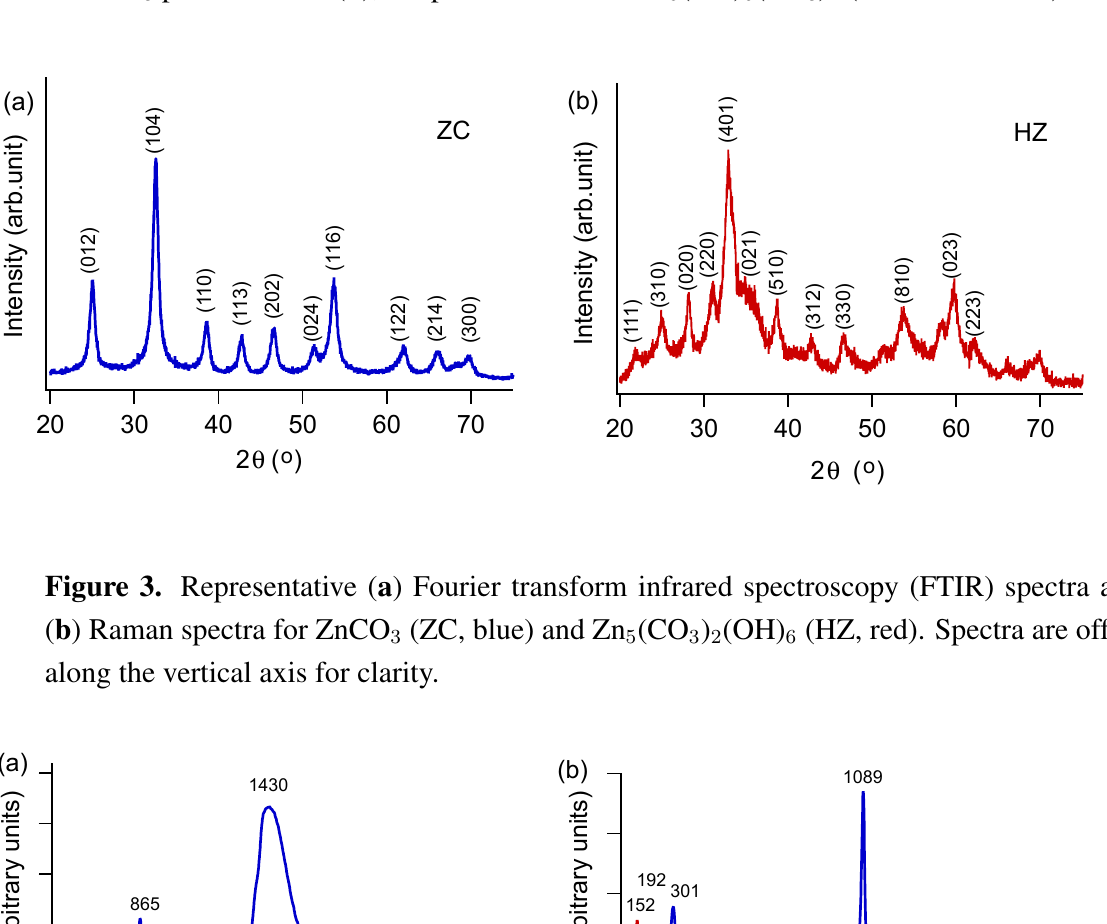
Figure 2. Representative indexed X-ray diffraction (XRD) data. In ( a ), all major peaks corresponding to ZnCO NaHCO precursors. In ( b ), the product matches Zn 3